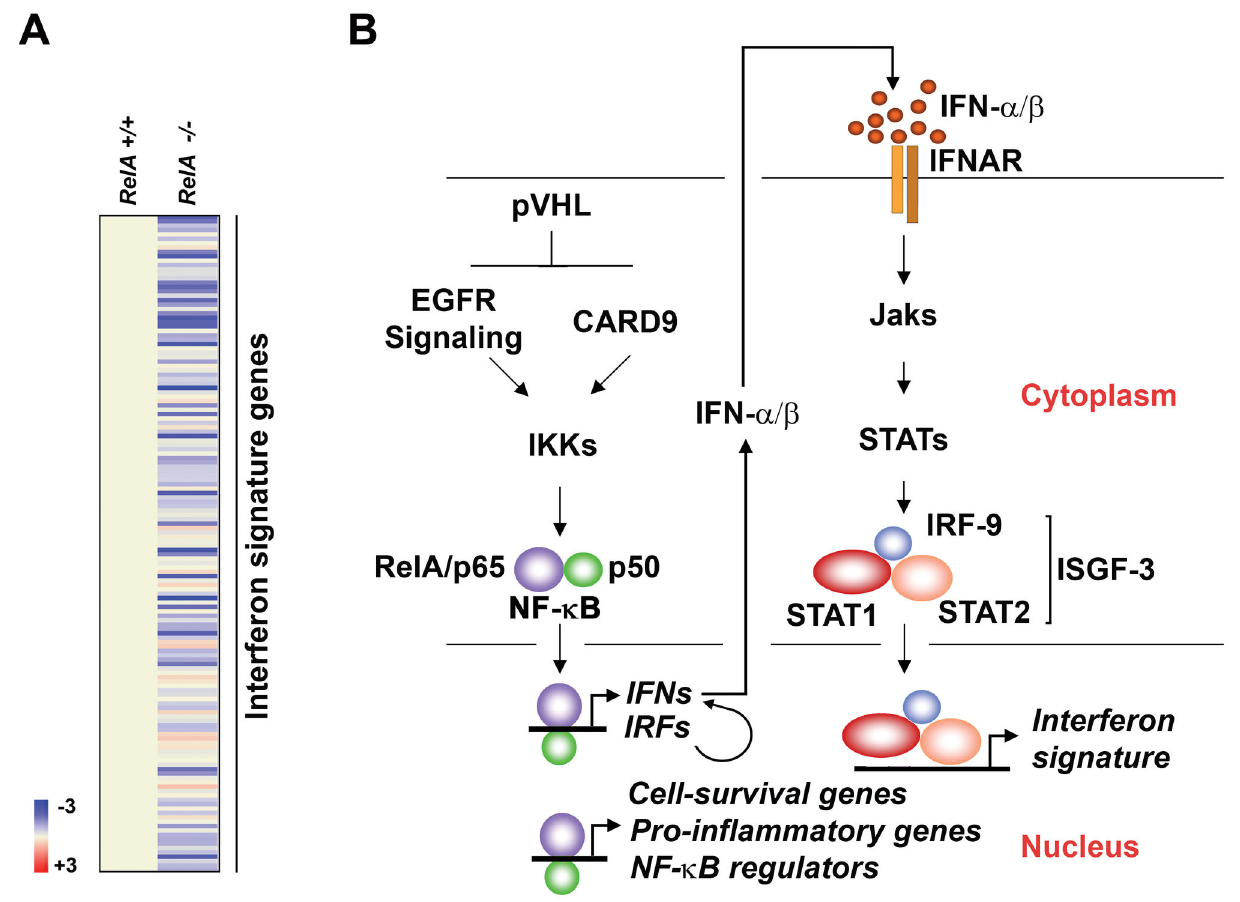
Figure 7. Model linking pVHL loss to NF-κB and IFN gene signatures. (a) Heatmap showing basal expression of the IFN gene signature in RelA+/+ and RelA-/- MEFs. Heat bar = fold-change (log scale). Expression levels in RelA+/+ were arbitrarily set to 1 2 (beige). Note that ~80% of IFN signature genes are expressed at lower basal levels in cells lacking RelA than in controls, indicative of a role for NF-κB in controlling ISG expression. (b) Schematic depicting the model presented in this study. ccRCC cells display elevated levels of NF-κB activity, perhaps as a result of result of constitutive EGFR or CARD9 activity stemming from loss of pVHL, that drives expression of cell-survival, pro-inflammatory, NF-κB regulatory genes, as well as genes encoding key nodes of type I interferon signaling (IFN-β, IRFs). Type I IFNs produced in this manner then function in an autocrine fashion to induce the expression of an IFN gene signature. doi: